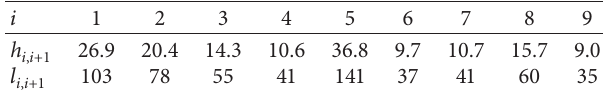
Table 5: The optimized departure/arrival time on origin/terminal station for each train. Train l i,i + 1 and i,i + 1 (min, km).